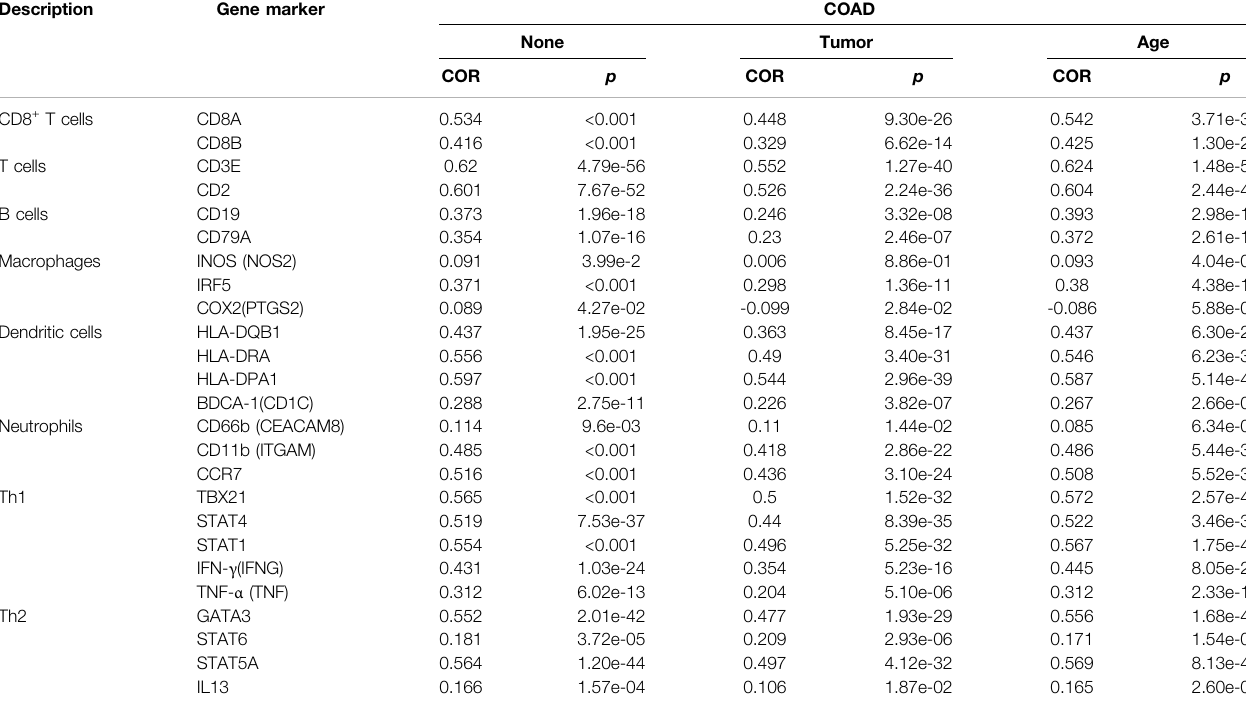
TABLE 2 | Correlation analysis between BTN3A2 and immune cell type markers in the TIMER database. Description